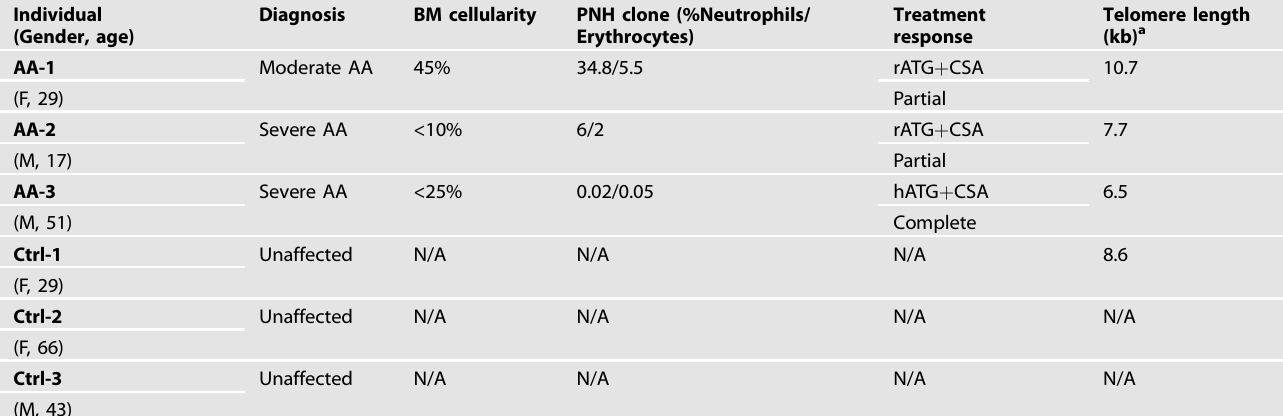
Table 1. Clinical characteristics of patients and healthy controls.